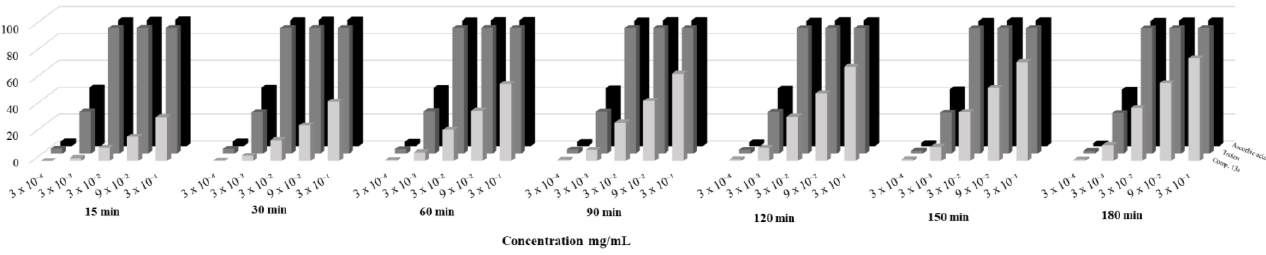
Figure 3. Analysis of DPPH radical scavenging activity for compound 13a at different concentrations and different time points. Data correspond to at least three independent experiments.